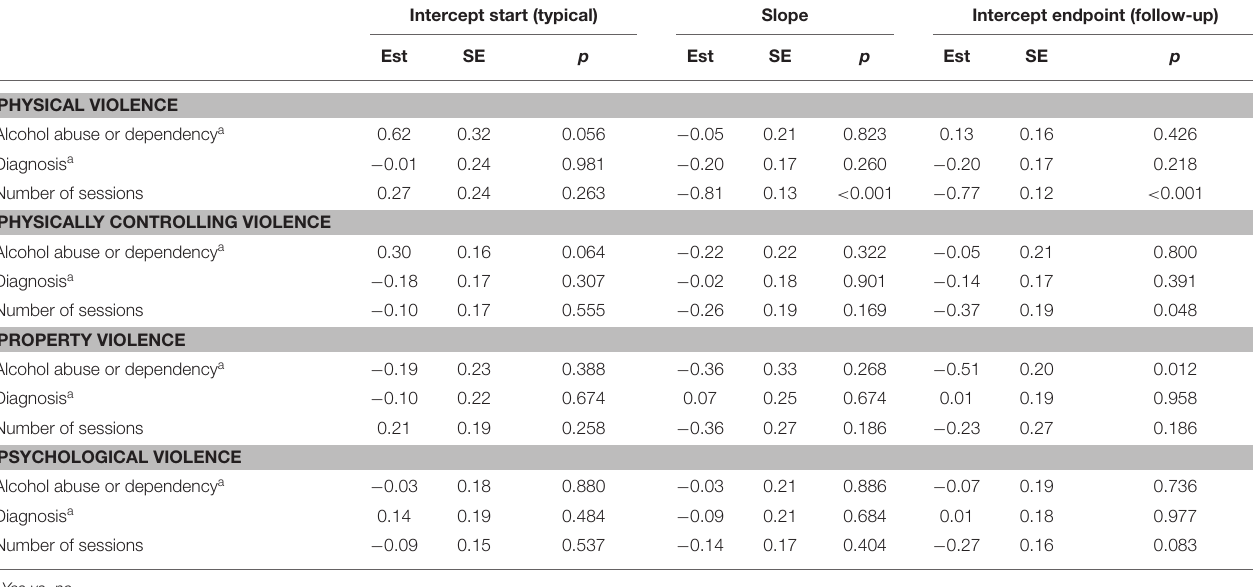
TABLE 3 | Standardized estimates and standard errors of associations between intercepts and slope of self-reported violence, and covariates ( n = 84). Intercept start (typical) Slope Intercept endpoint (follow-up)